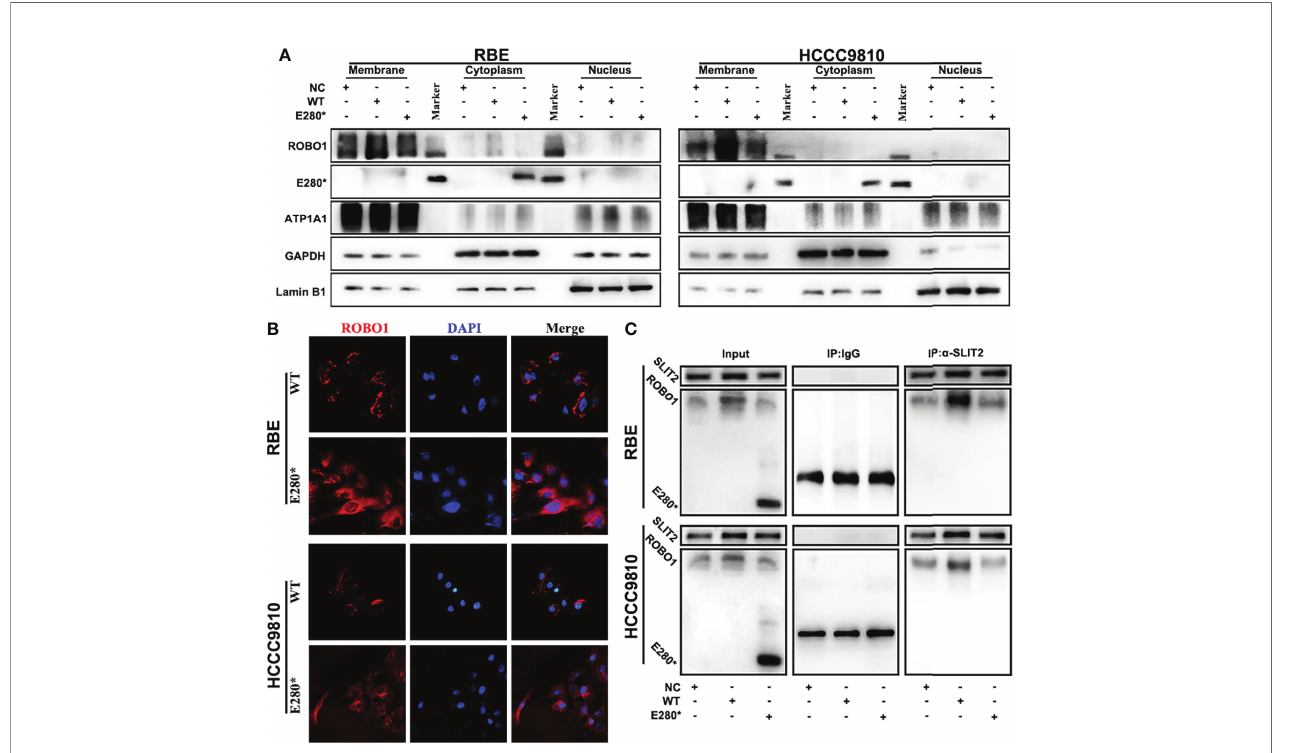
FIGURE 4 | ROBO1 E280 * interrupted SLIT2/ROBO1 transmembrane signal transduction in cholangiocarcinoma cells. (A) Subcellular fractionation analysis showed the membrane localization of ROBO1 WT and the cytoplasmic localization of ROBO1 E280 * in RBE cells. (B) Immuno fl uorescence staining revealed the subcellular localization of ROBO1 WT and ROBO1 E280 * in RBE cells. (C) Co-immunoprecipitation, performed using either control IgG or anti-SLIT2 antibodies, showed that the ROBO1 E280 * was not detected in the immunoprecipitates of the anti-SLIT2